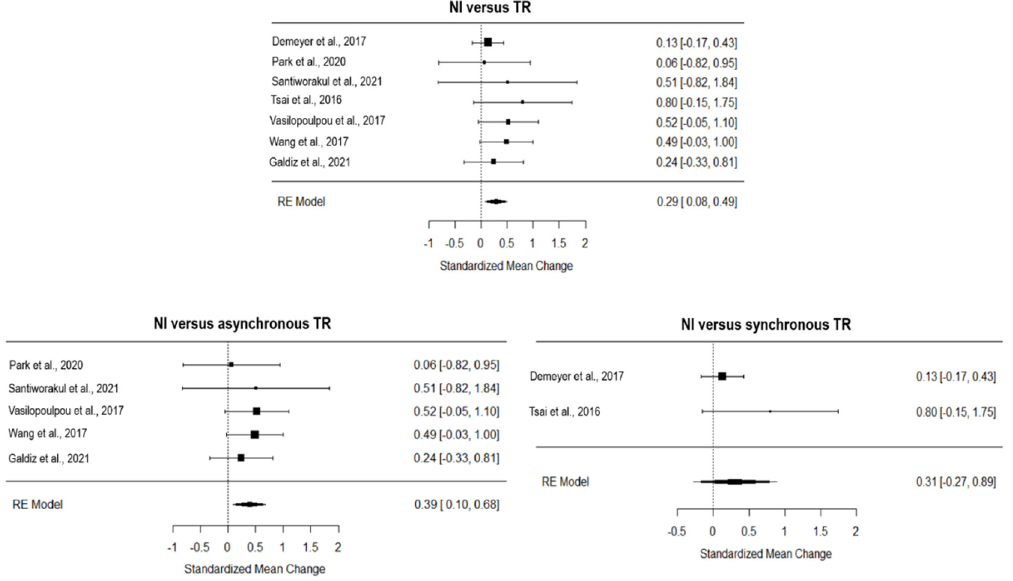
Figure 2. Forest plot on the effect of TR on functional capacity compared to NI. TR, TR; NI, no intervention [8,29,33–35,38,41]. Ref. [31] was not included in the analysis based on the leave-one- out analysis.